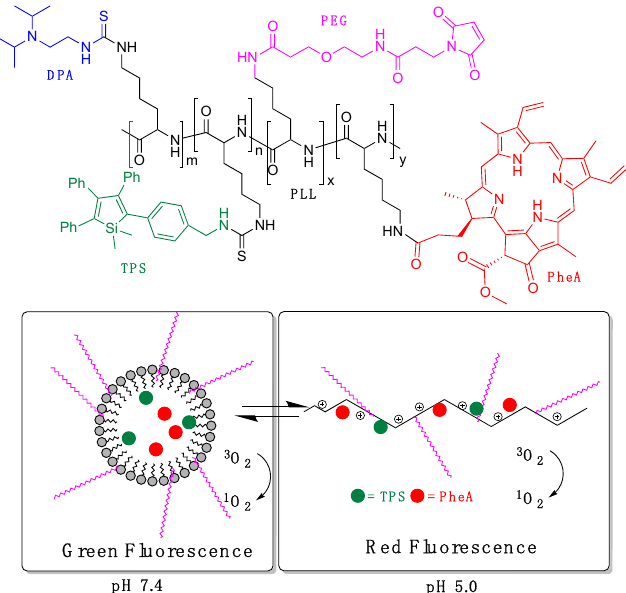
Figure 6. Structure of PLL- g -PEG/DPA/TPS/PheA (probe 1) and schematic illustration of the pH-activable probe 1.